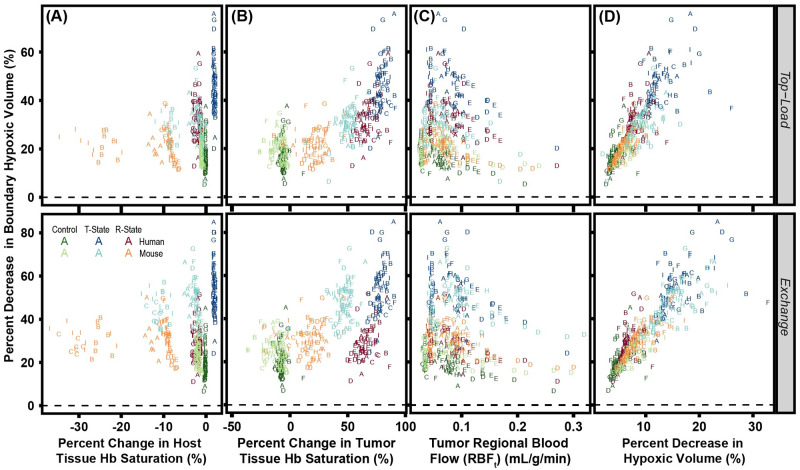
The effect of (A) host tissue Hb saturation, (B) tumor tissue Hb saturation, (C) tumor RBF and (D) percent decrease in total tumor hypoxic volume on the percent changes in the boundary hypoxic volume.The baseline (unsupplemented) condition is depicted as the dashed line at zero. Letters labeling each data point indicate the vessel bed configuration for that artificial tumor construct. The non O2 carrying control is green, R-State PolyhHb is red, and T-State PolyhHb is blue.